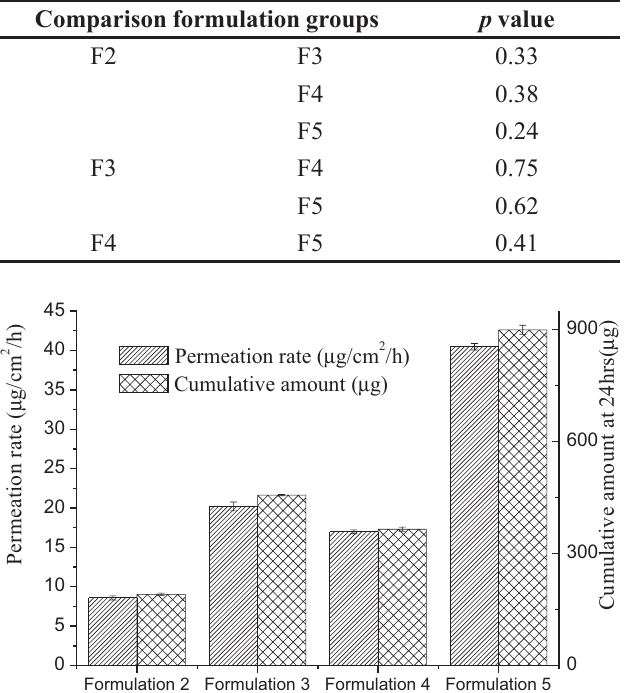
TABLE V - In vitro release of formulations with different pressure sensitive adhesives